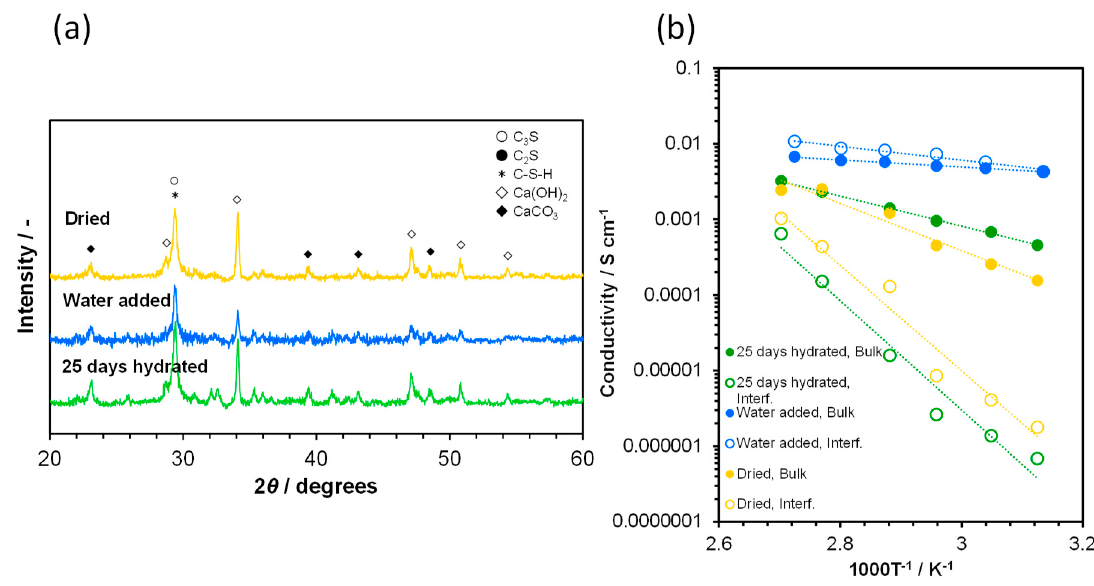
Figure 4. Characterization of the highly hydrated sample before and after addition of 15% water, and after drying. ( a ) XRD patterns. ( b ) Temperature dependence of the bulk and interfacial conductivities.